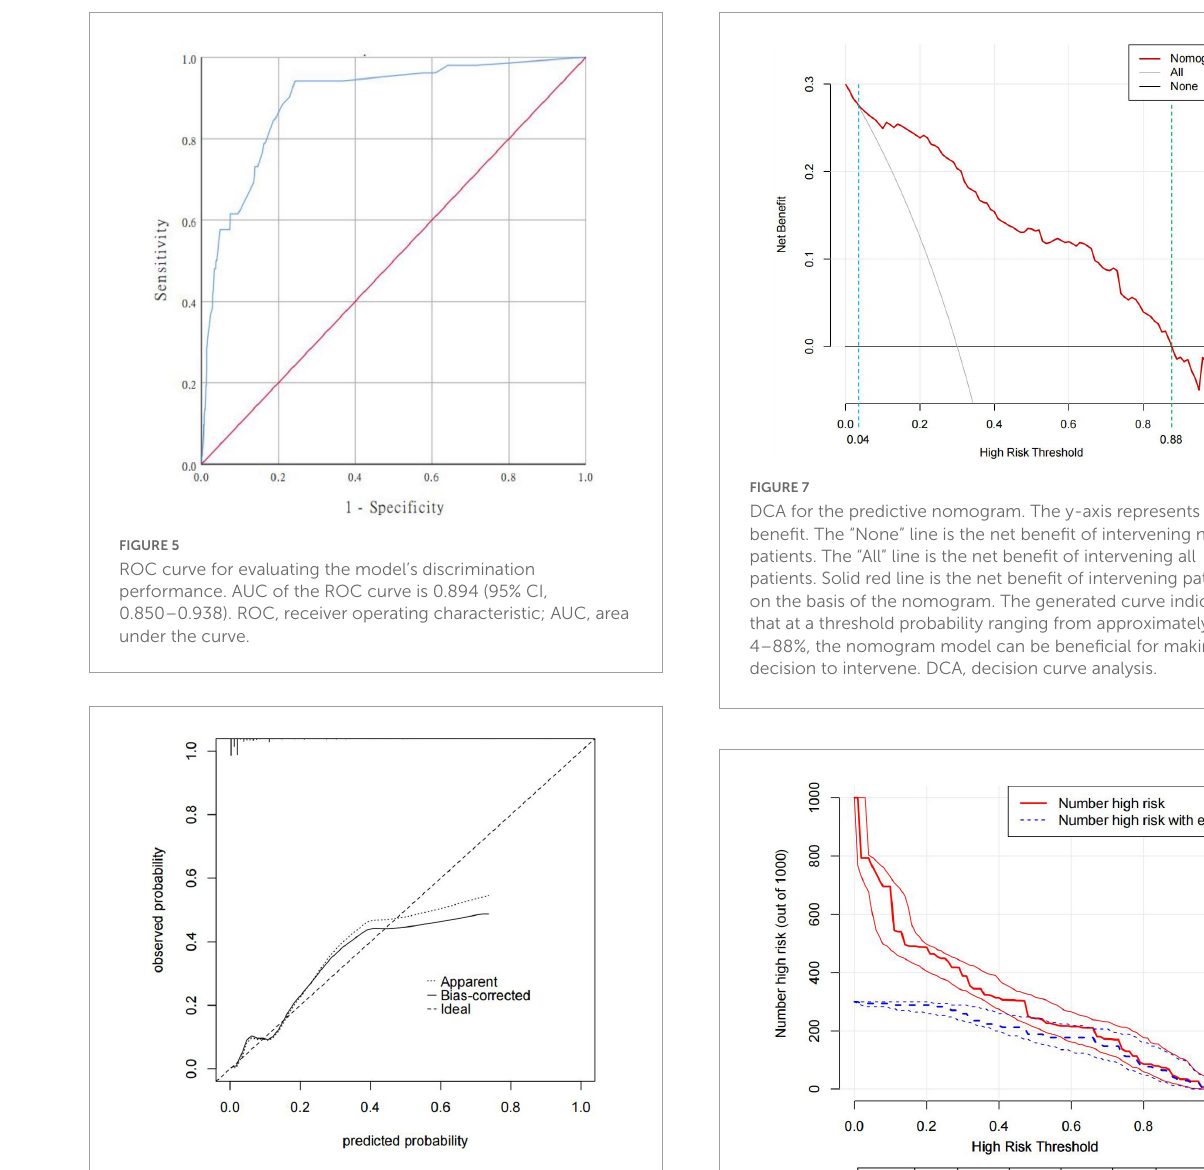
FIGURE6 Nomogram calibration curve. The x-axis represents the nomogram-predicted probability, and the y-axis represents the actual probability of the nomogram. The “Ideal” line indicates perfect prediction by an ideal model. The “Apparent” line depicts the model’s performance, and the black solid line is bias-corrected by bootstrapping (B = 1,000 repetitions), indicating observed nomogram performance. C-index of the nomogram calibration curve is 0.905 (95% CI, 0.865–0.945).